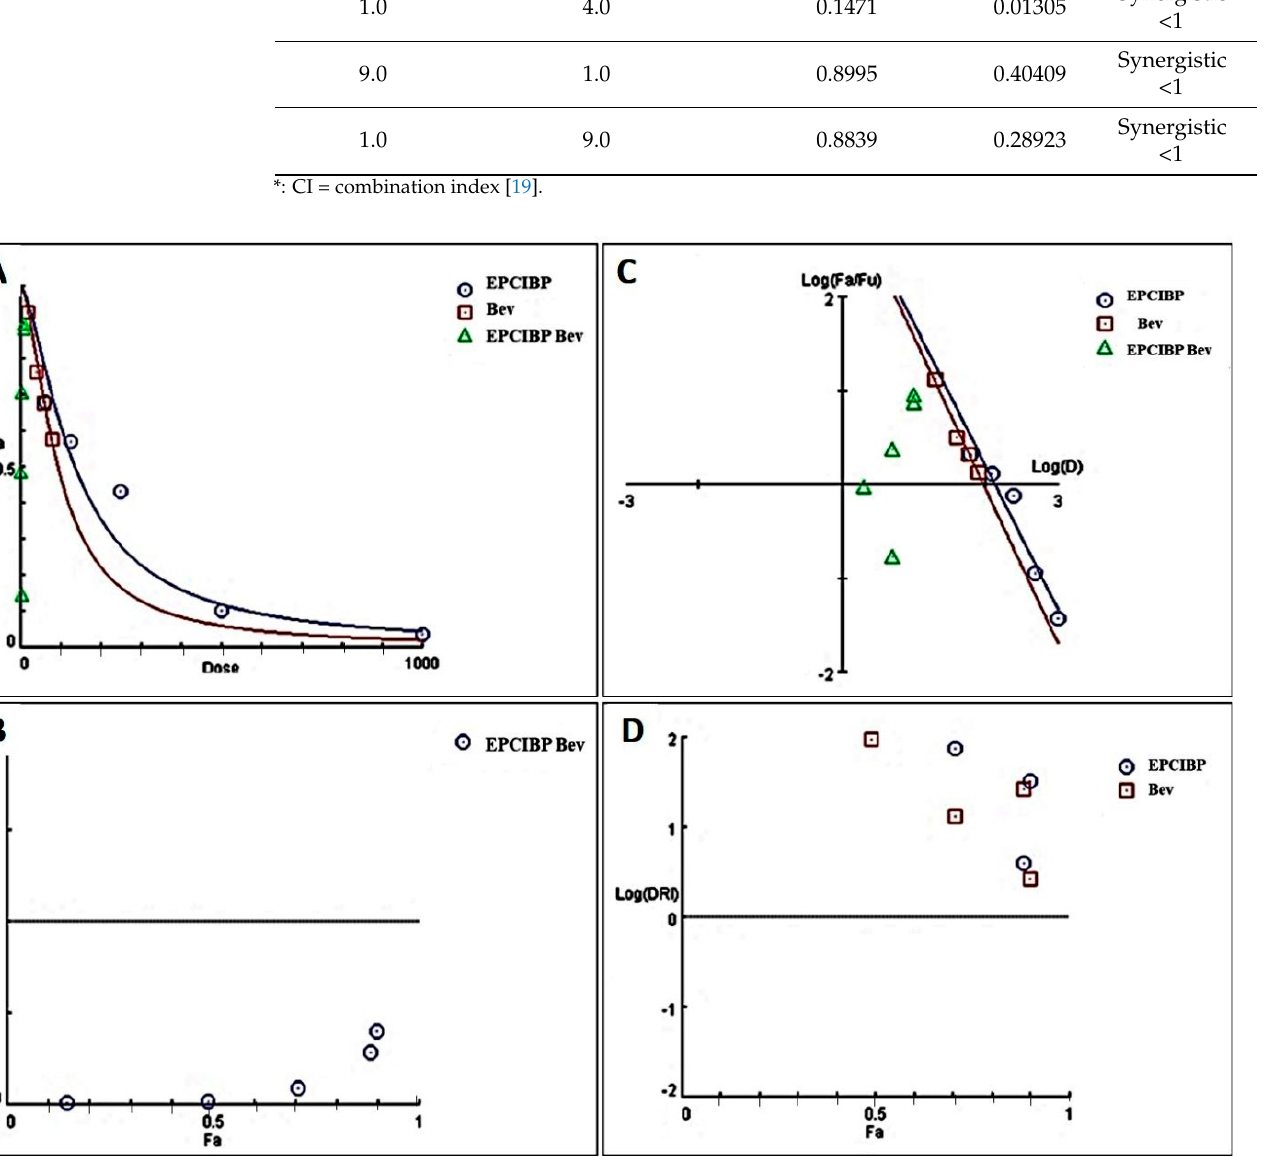
Figure 9. Combination index histograms. ( A ) The dose–effect curve showing combination doses on perpendicular axes that correlate to both drug levels; ( B ) the combination index plot showing an effective synergy (CI < 1) for all pairings; ( C ) plot of the treatments’ and drugs’ combined median effect levels; ( D ) plot of the non-constant combination of EPCIBP and Bev.’s log dose-reduction index (Log DRI). Fa: Default effect